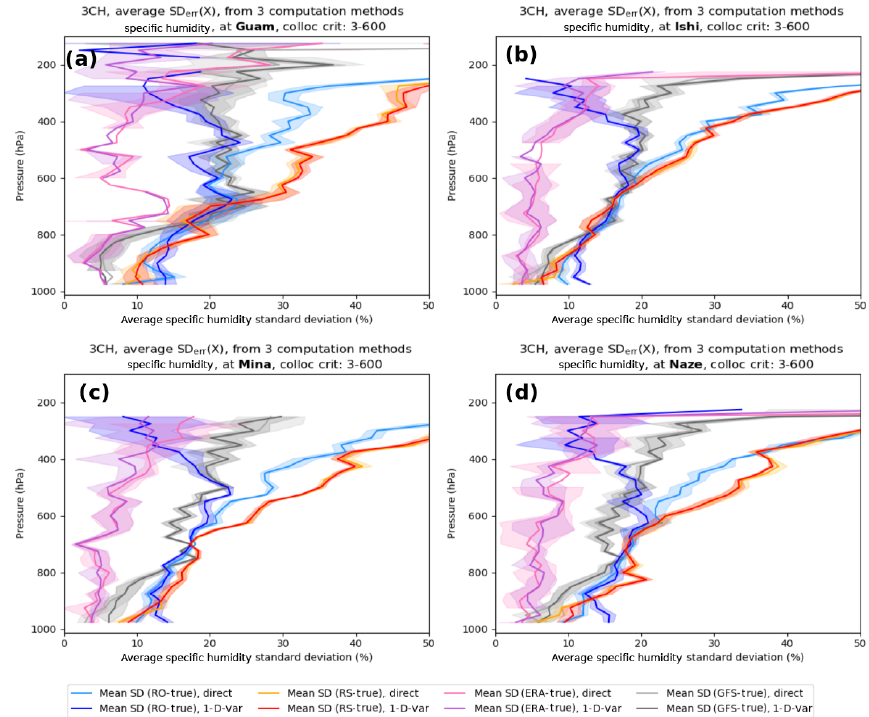
Figure B1. Mean and standard deviations (shading) of the three estimates of normalized specific humidity using RO-direct and RO 1D-VAR at (a) Guam, (b) Ishi, (c) Mina, and (d)